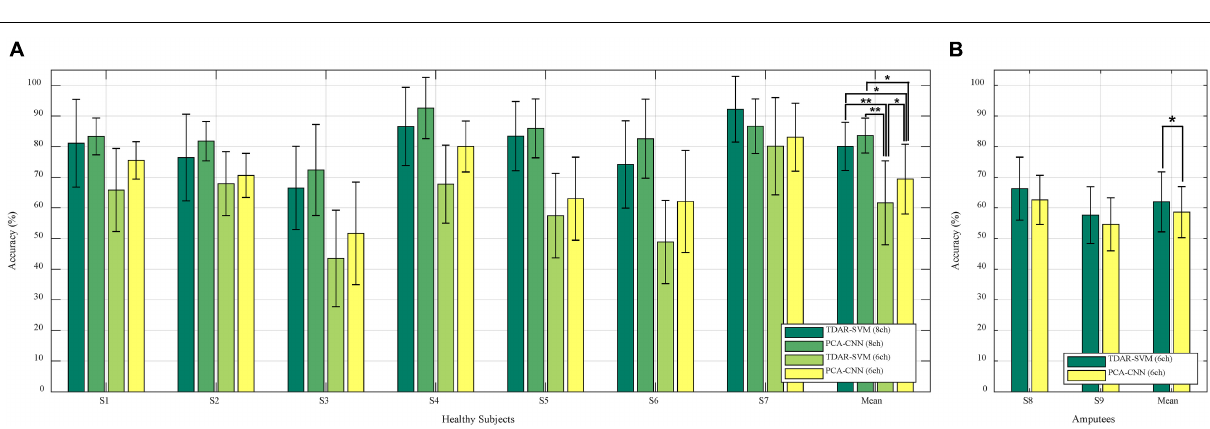
[ F (1,6) = 8.84, p = 0.025)]. As the interaction effect